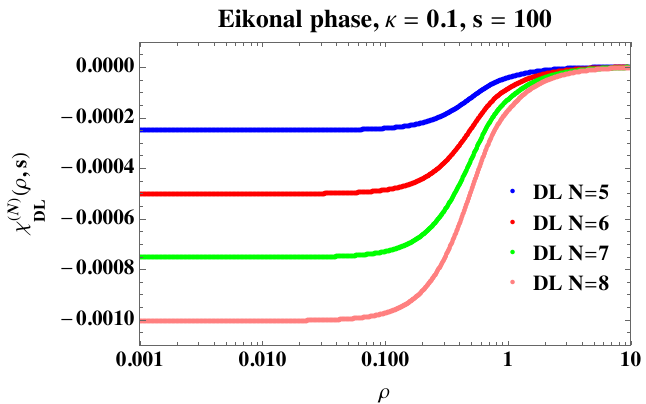
Figure 9 . Contribution to the eikonal phase from DLs in di(cid:11)erent supergravities as a function of the impact parameter (cid:26) with (cid:20) = 0 : 1 and s =